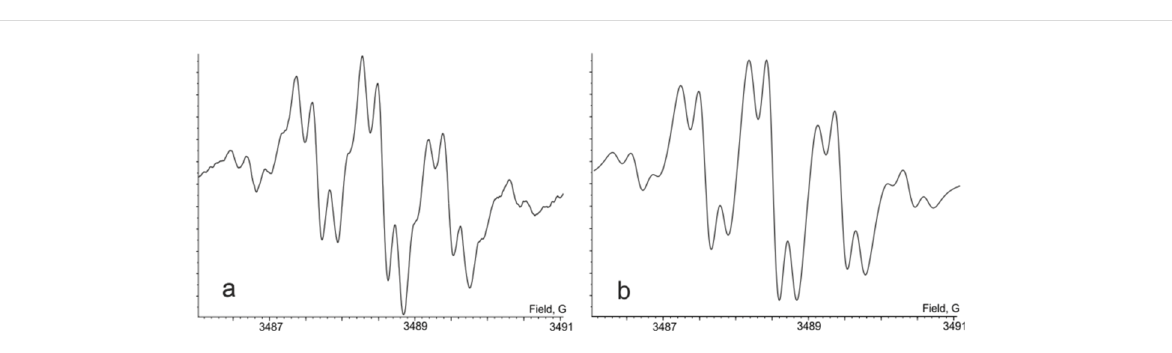
Figure 5: The well-resolved EPR spectrum of (1 · − )H 2 in dimethoxyethane (diluted solution), 273 K: a) experimental and b)